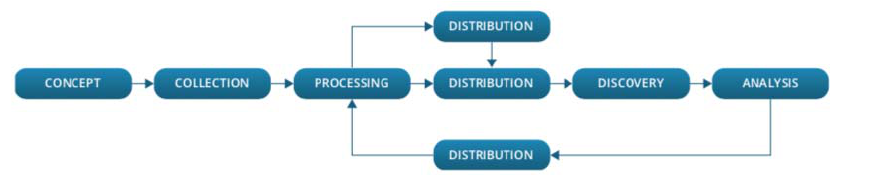
Figure 2: Data cycle. Source: DDI